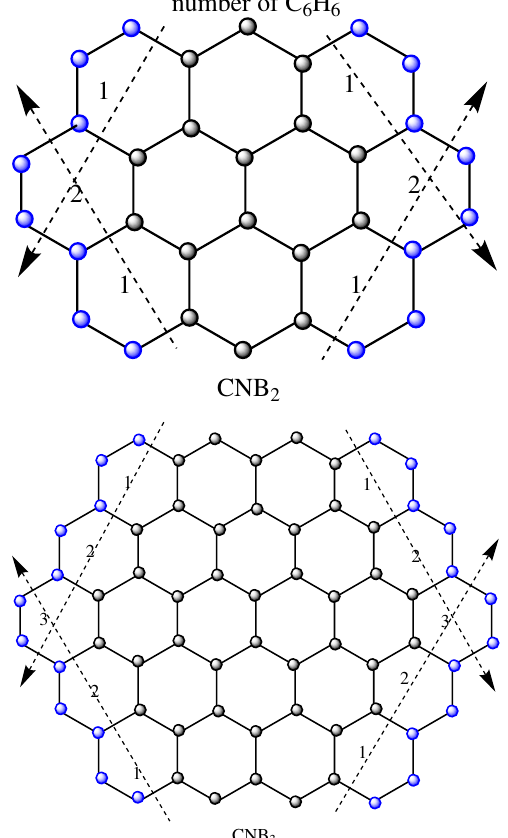
Figure 3. Circumnaphthalene series of benzenoid CNB n